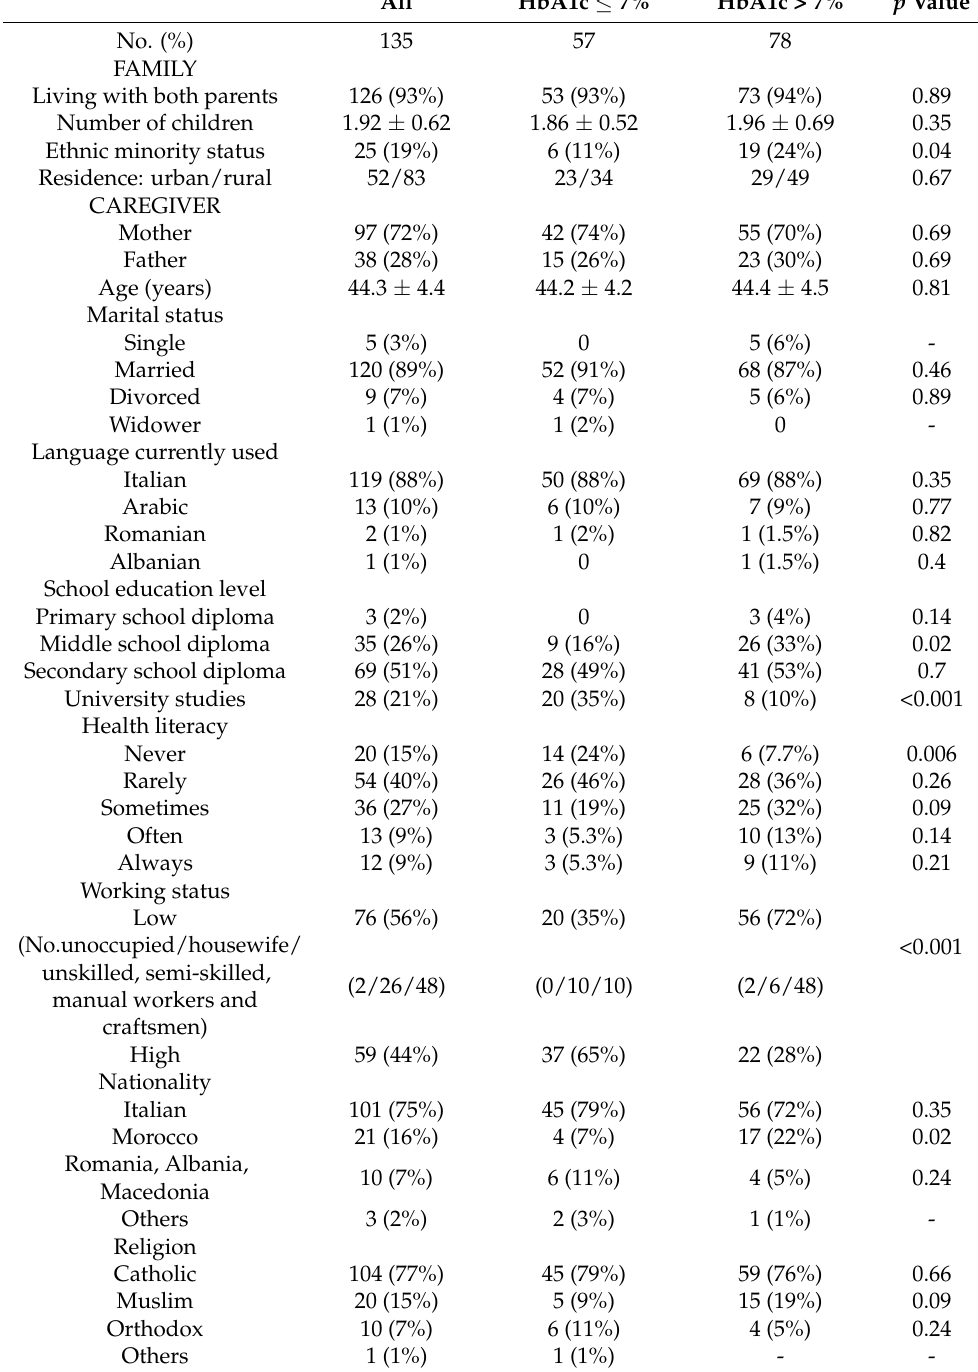
Table 2. Family and caregiver characteristics. Mean ±